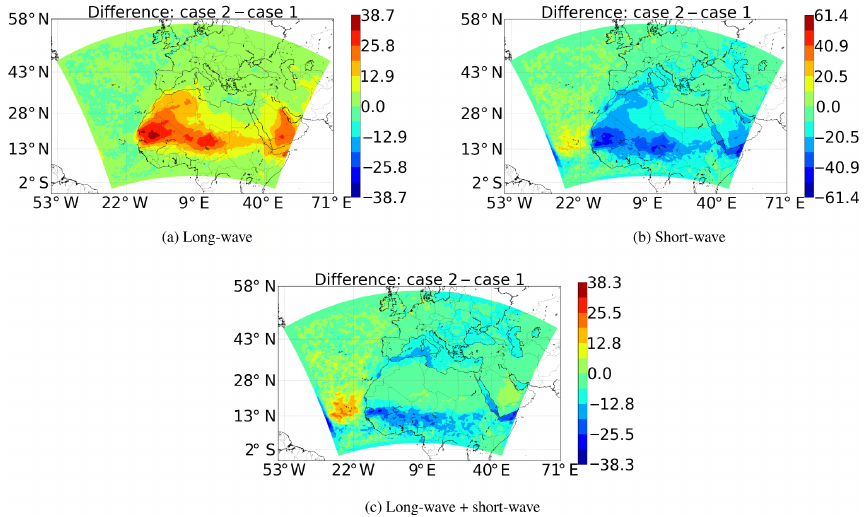
Figure 7. Difference in the WRF radiation budget at the ground surface between both online simulations (all-sky fluxes). Fluxes are in Wm − 2 and are averaged in time over the period ranging from 1 June to 14 July.